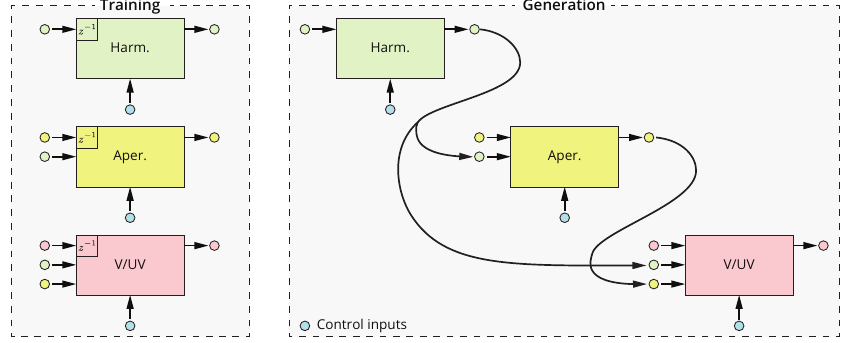
Figure 4. Diagram depicting the cascaded multistream architecture for training and generation phases. The “ z − 1 ” blocks represent unit delays. The upward inputs represent control inputs, shared between all streams. Autoregressive connections in generation phase are not